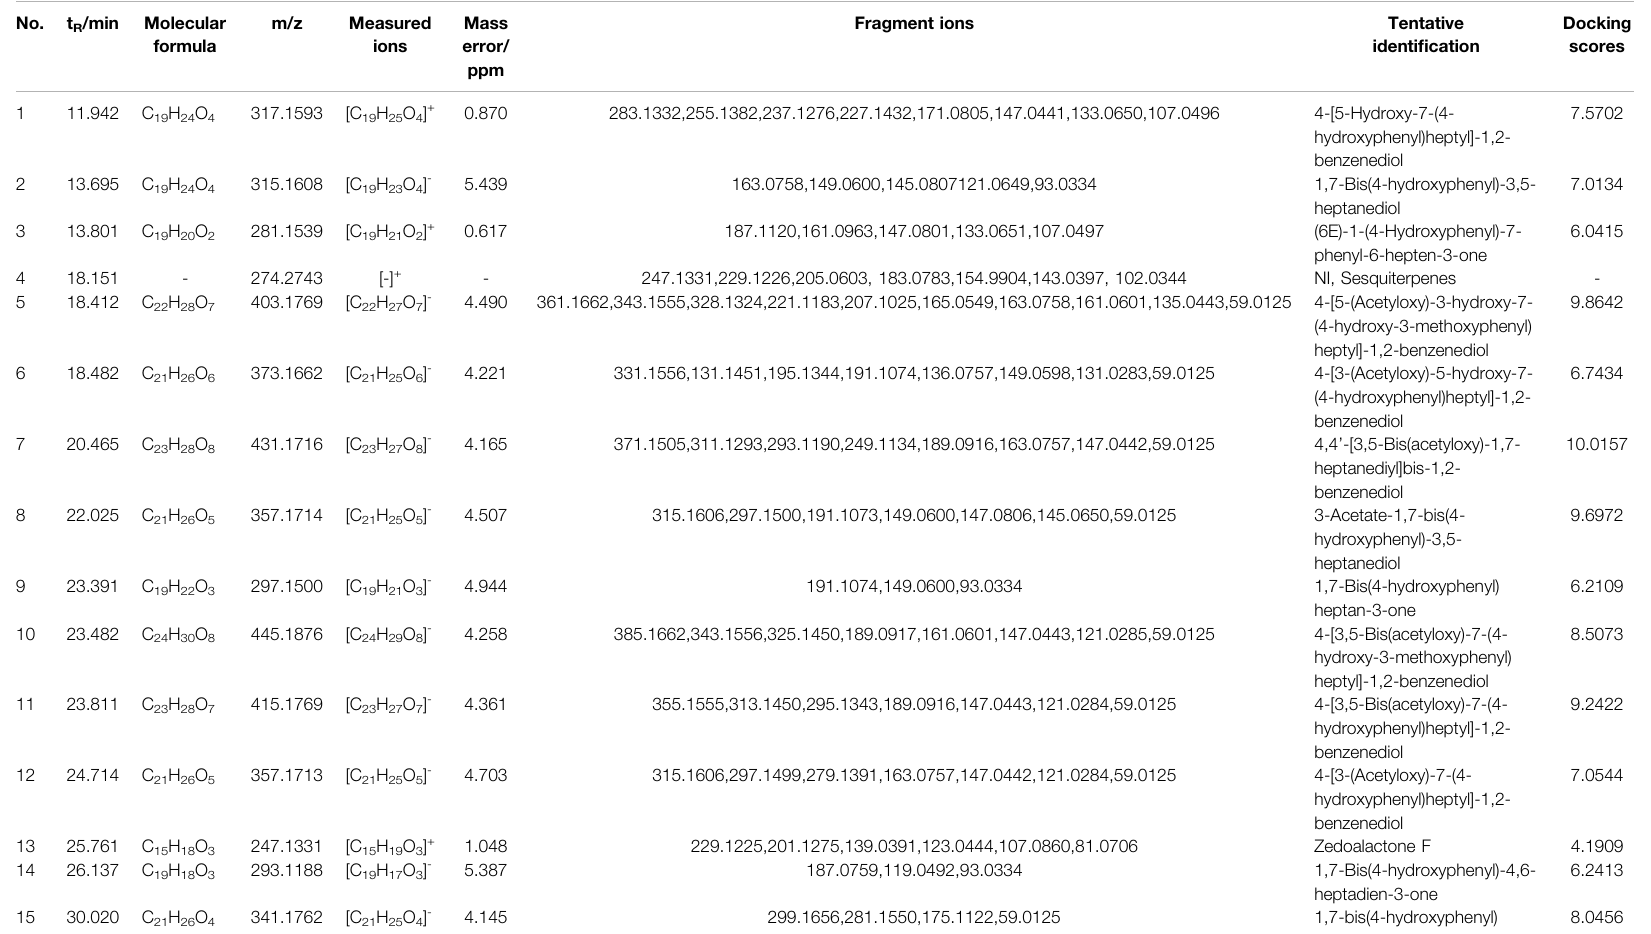
TABLE 1 | Identi fi cation and molecular docking of active compounds in AUF step.